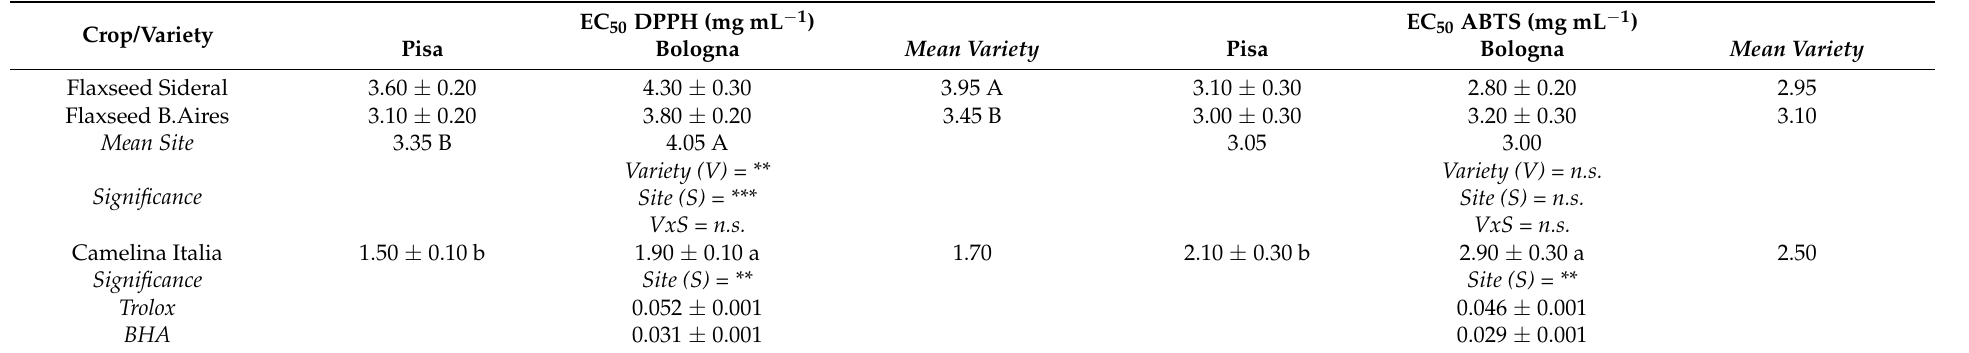
Table 2. Anti-radical activity (expressed as EC 50 and evaluated by DPPH and ABTS assays) in the defatted seed meal of flaxseed (Sideral and Buenos Aires) and camelina (Italia) in